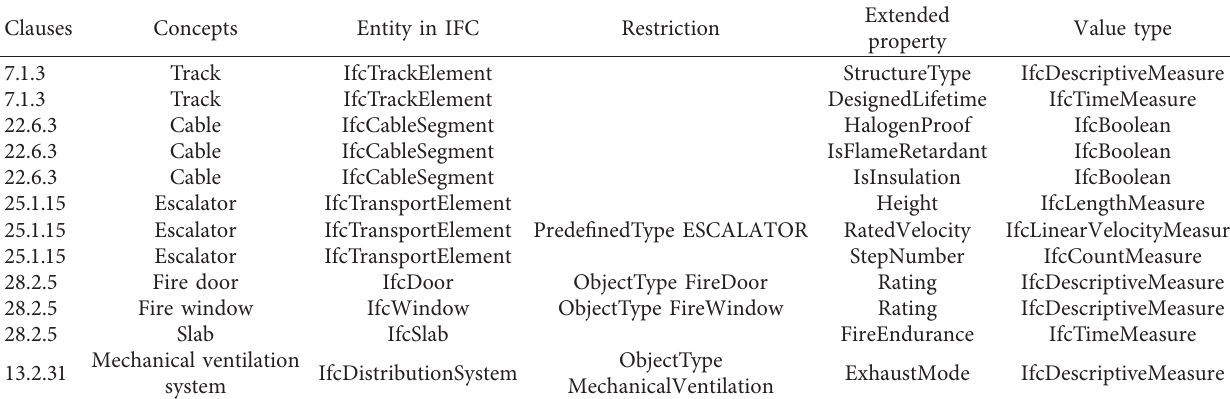
Table 5: Property extension content mapping